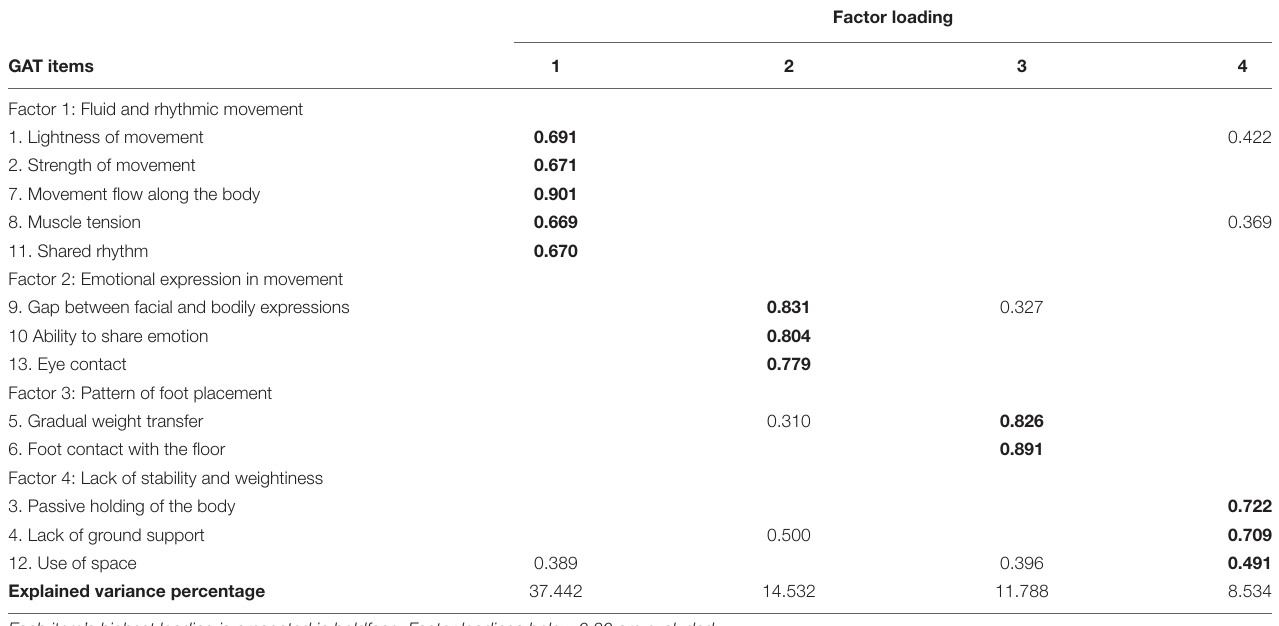
TABLE 7 | Loadings of Grounding Assessment Tool (GAT) factors after varimax rotation and the explained variance percentage for each factor.